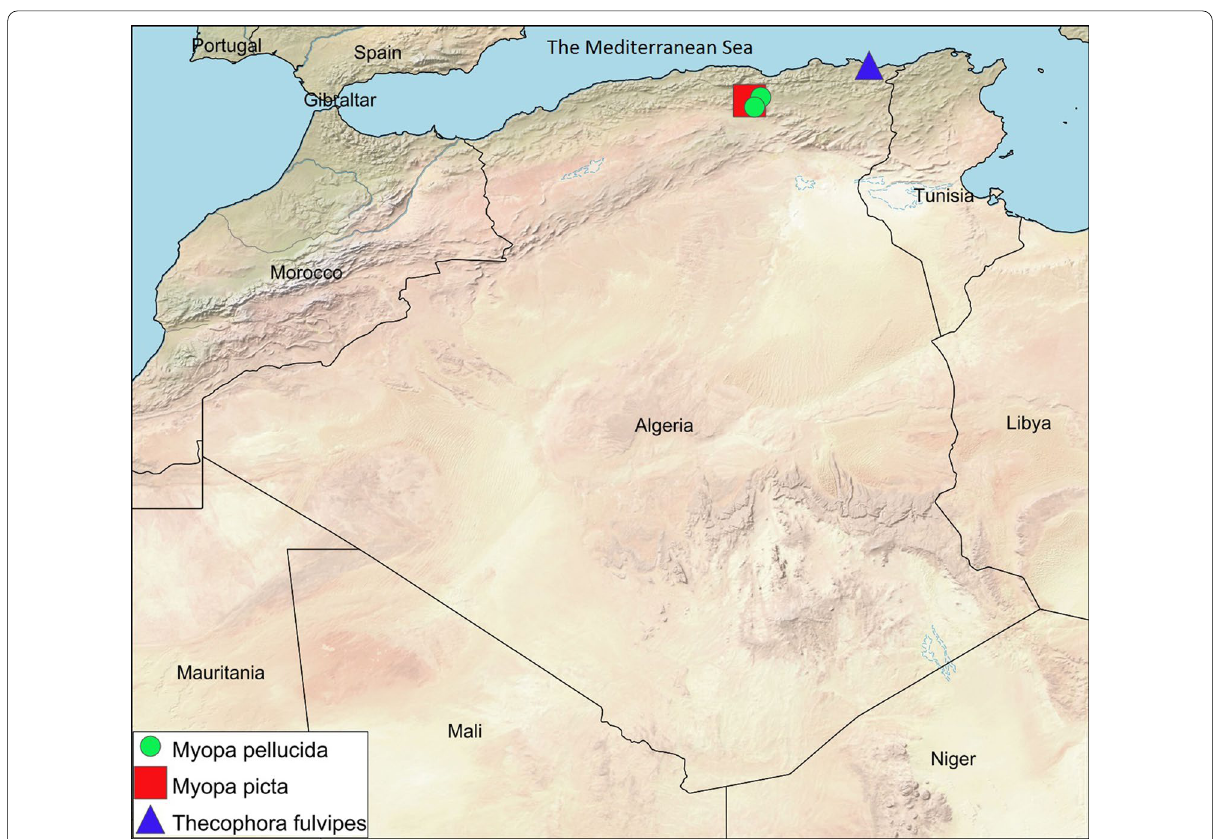
Fig. 8 A distribution map of newly recorded conopid species from